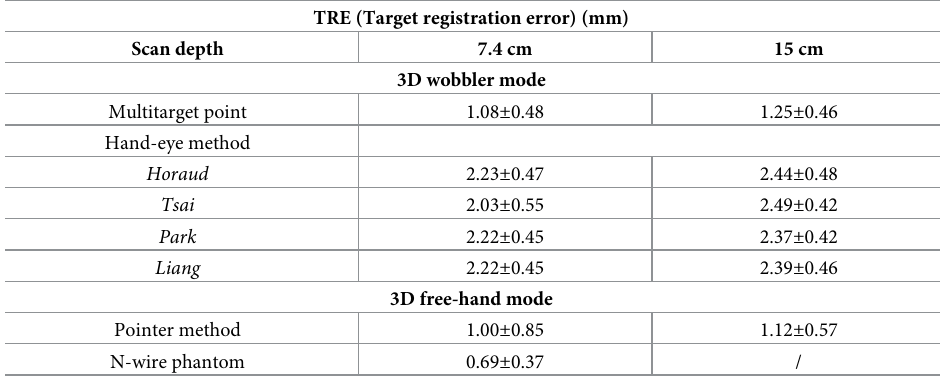
Table 2. Target registration error for the 3D and 2D calibration techniques.